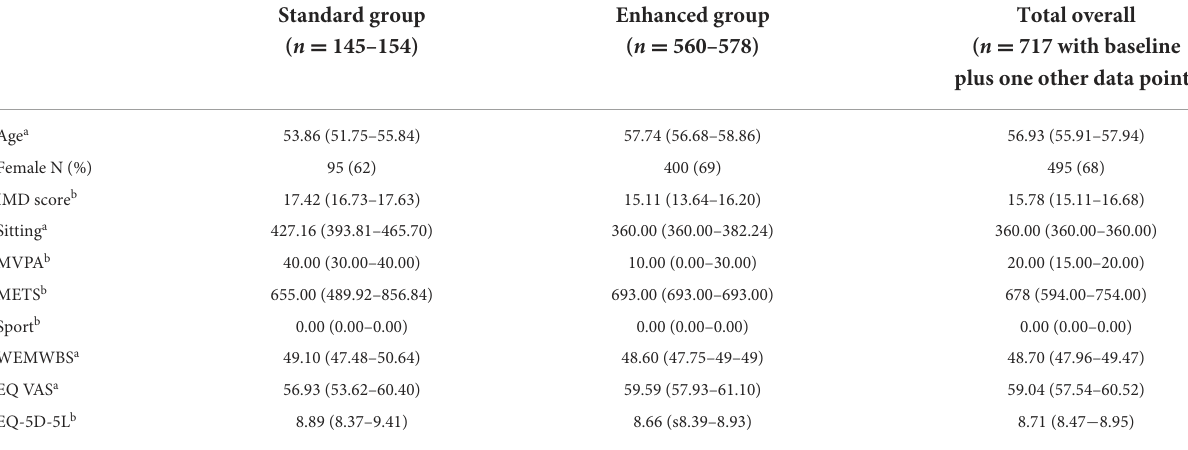
TABLE 1 Baseline characteristics of programme users who completed at least one follow-up questionnaire, by planned delivery group and